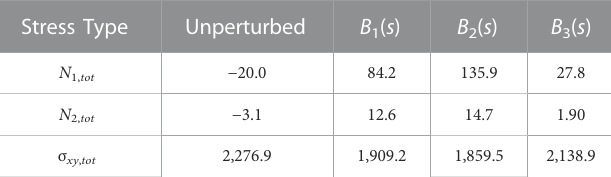
TABLE 1 Total value of stress types by integration of area under the curve in Figure 4for each stiffness pro fi le. The unperturbed column represents a fi lament without a supplied perturbation so it rotates like a rigid rod in shear fl ow (corresponding to the dotted magenta lines in Figure